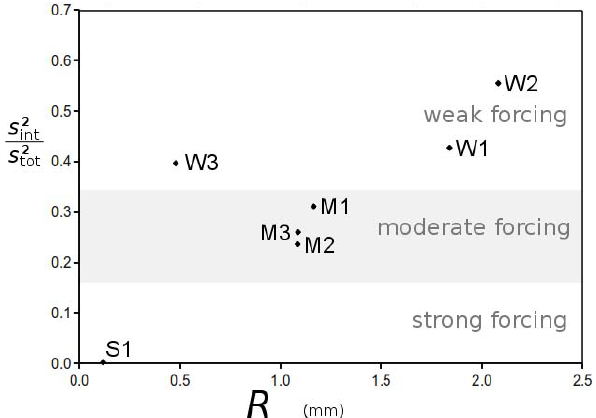
Fig. 9. Ratio of internal ( s 2 ) to total ( s 2 tot ) sample variance of the int smoothed precipitation accumulations over the hour preceding the 6, 12, 18, 24, 30, 36, 42, and 48h forecast time as a function of the ensemble average accumulated precipitation over the 48h forecast period R